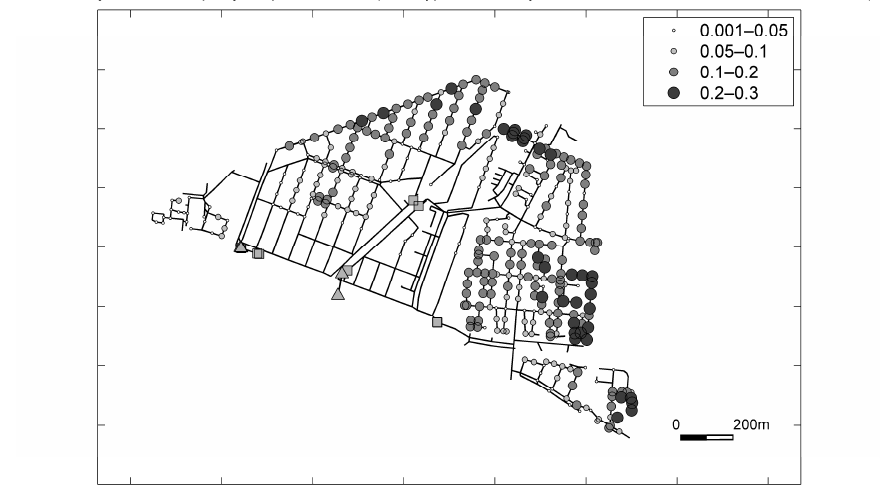
Figure 11. Example of spatial distribution of infection probability for children per year per manhole for a specific system state (i.e., Monte Carlo run) of the ‘Tuindorp’ catchment.